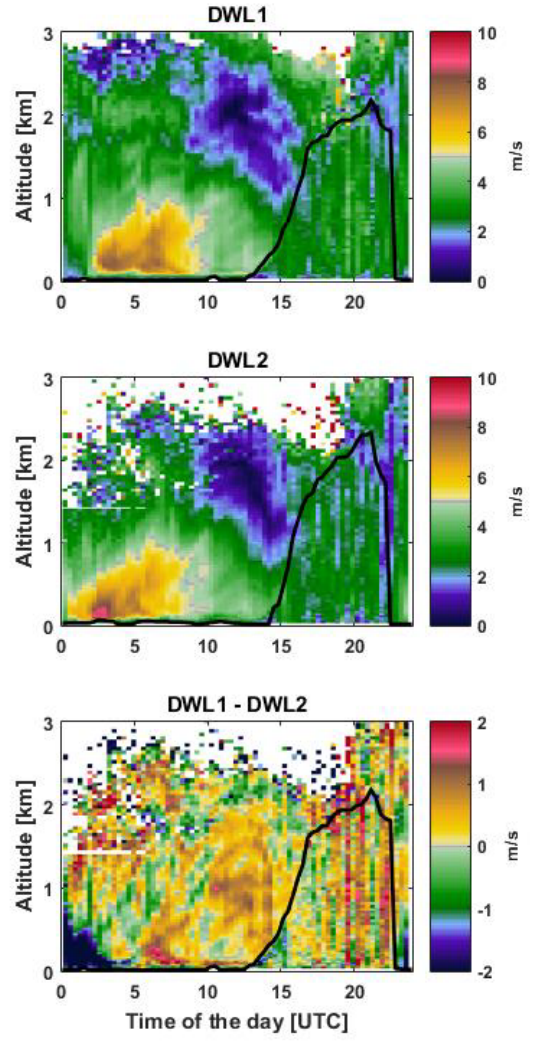
Figure 4: Time-height cross section showing horizontal wind speed profiles measured by DWL1 (top), and DWL2 (middle) on 26 September 2017. The black solid lines represent the measured mixing layer height at the two sites. The bottom panel shows the difference between the top two